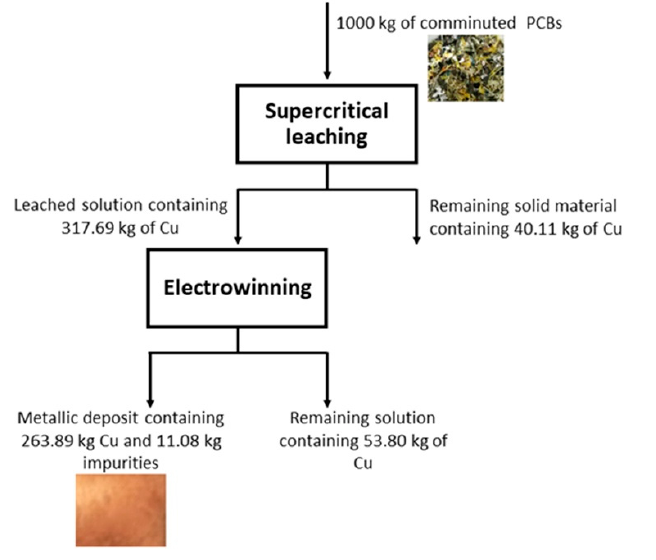
Figure 13. Mass balance for copper recovery from supercritical leaching to electrowinning under the best conditions.